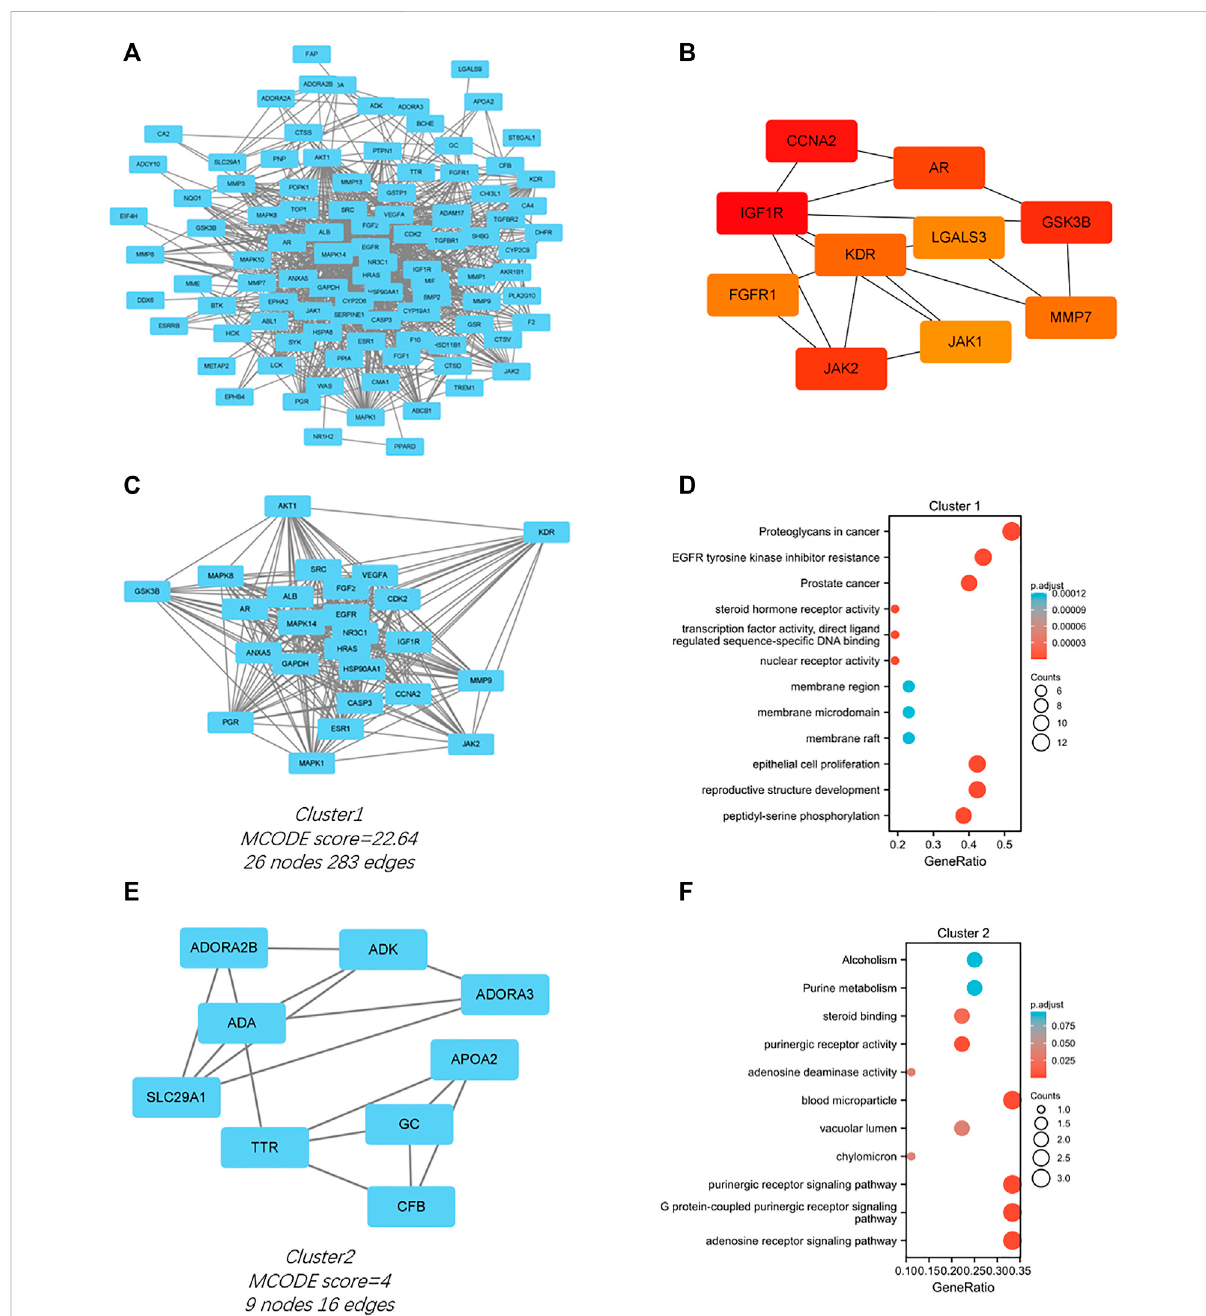
FIGURE 4 PPI network of the intersected 103 mutual genes, the top 10 identi fi ed hub gene web, and cluster modules extracted by MCODE. (A) PPI network of the 143 intersected genes; (B) a network of top 10 hub genes from the PPI network; Two cluster modules extracted by MCODE. Cluster 1 (C) had higher cluster score (MCODE score = 22.64), followed by cluster 2 (E) (MCODE score = 4). GO and KEGG enrichment analysis of the modular genes in cluster 1 (D) and cluster 2 (F) . Adjusted p value < 0.05 was considered signi fi